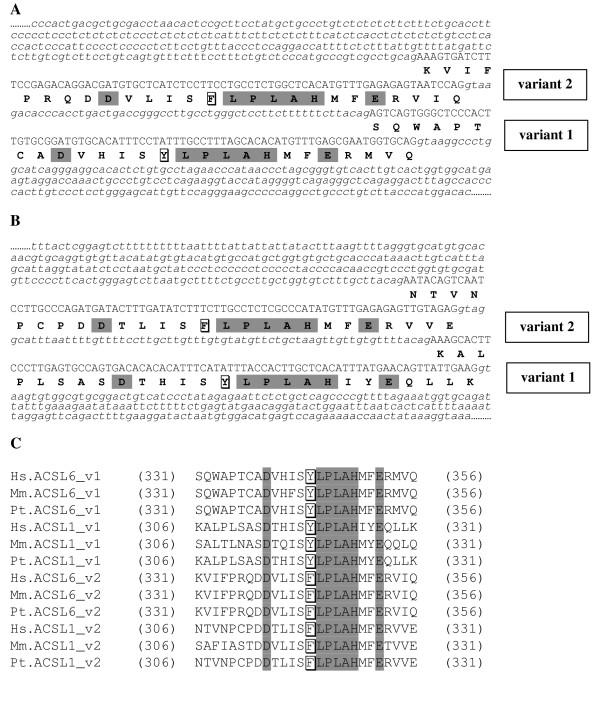
Genomic and amino acid sequences of the gate-domain region of human ACSL6 and ACSL1. A and B: Sequence of exons and introns of human ACSL6 (A) and ACSL1 (B) are represented by capitalized and small italics letters, respectively. The F and Y residues of the Gate domain of variant 2 and 1, respectively, are boxed. C: Amino acids alignment of the Gate-domain motifs for known and predicted spliced variants. Highly conserved residues are shaded. Position of the first and last residues shown is indicated on the left and right, respectively. Abbreviations are: Hs, Homo sapiens; Ms, Mus musculus; Pt, Pan troglodytes.